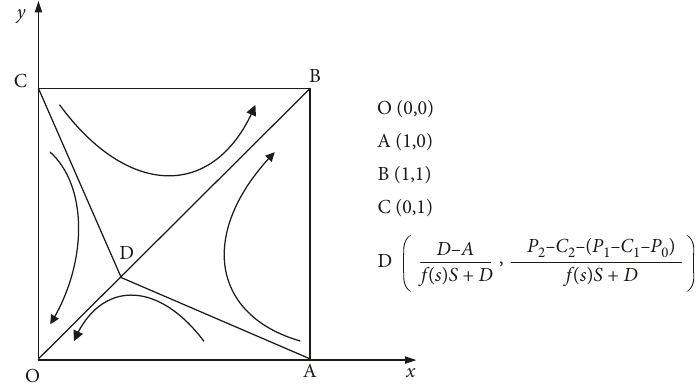
Figure 5: Phase diagram of system evolutionary